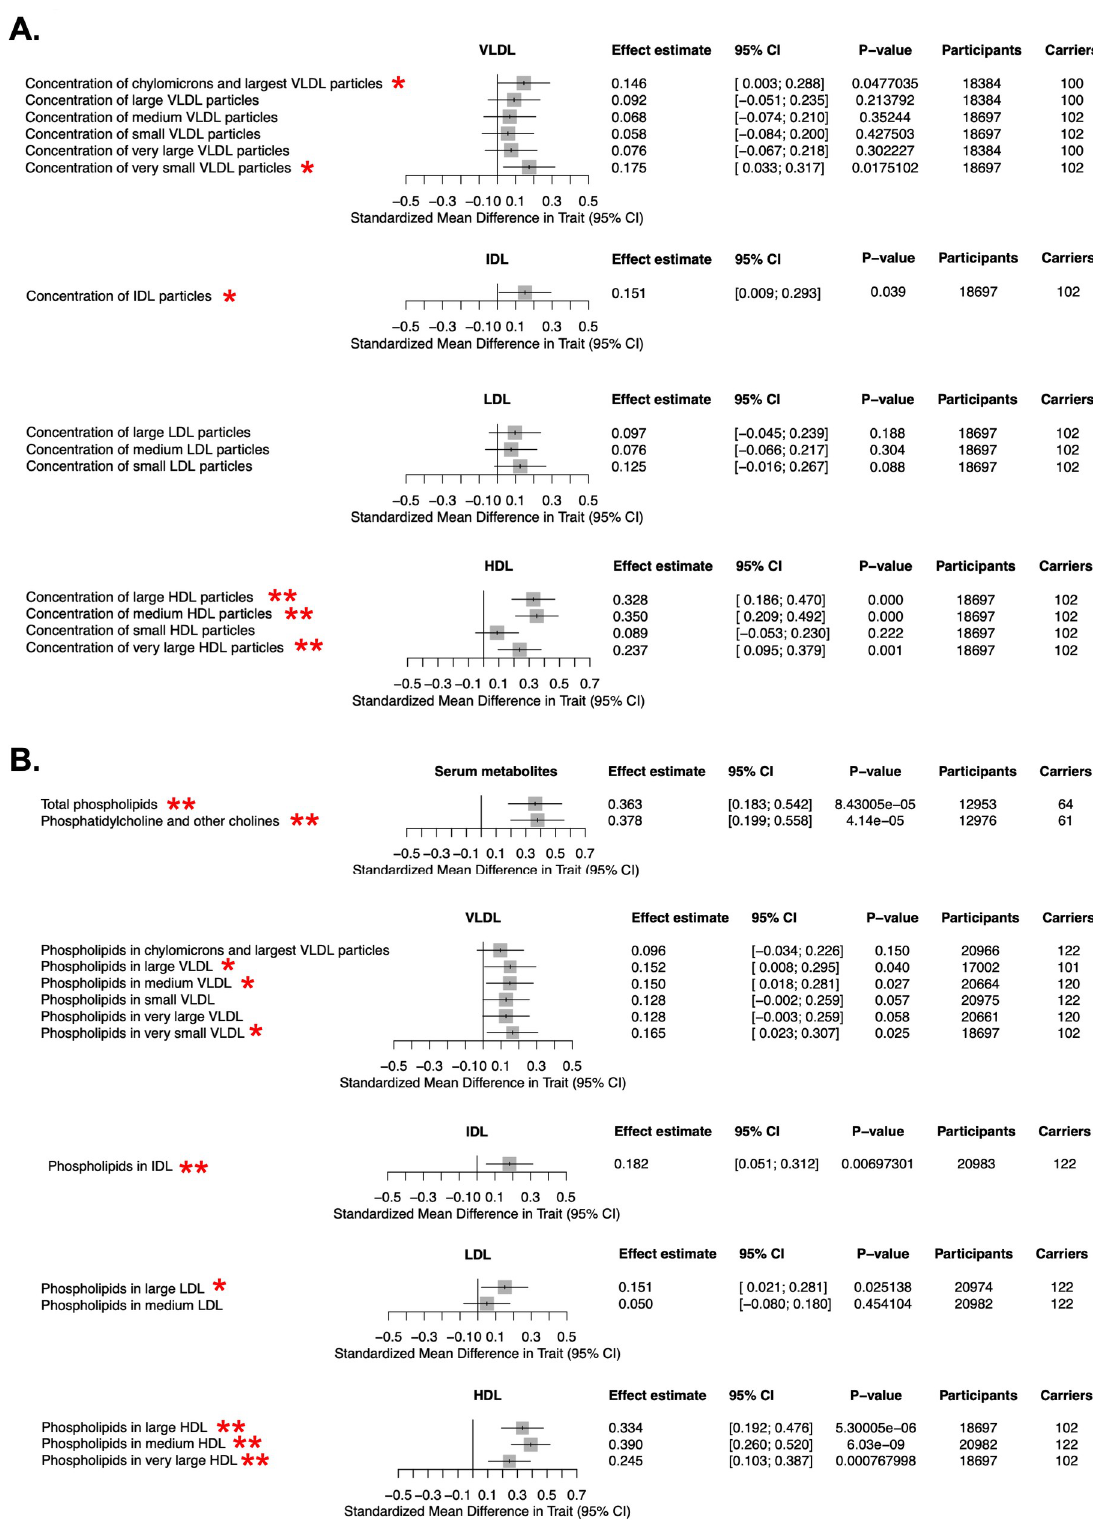
Fig 2. Association of LIPG p.Asn396Ser variant with serum lipoprotein and lipid metabolites by NMR. A. Association of LIPG p. Asn396Ser variant with lipoprotein subclass concentrations measured through NMR spectroscopy from human serum from a